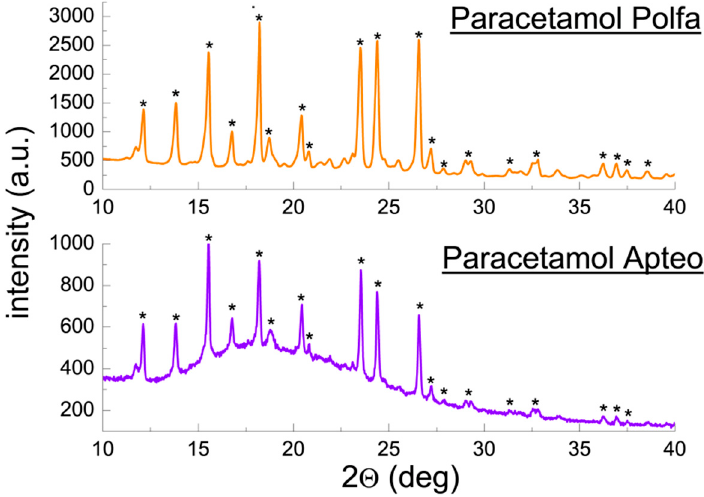
Figure 4. Diffraction patterns for the drugs Paracetamol Polfa and Paracetamol Apteo. (*—acetaminophen). Table 3. Comparison of experimental data with data from ICDD database for the drugs Paracetamol Polfa and Paracetamol Apteo containing only ACP as API.